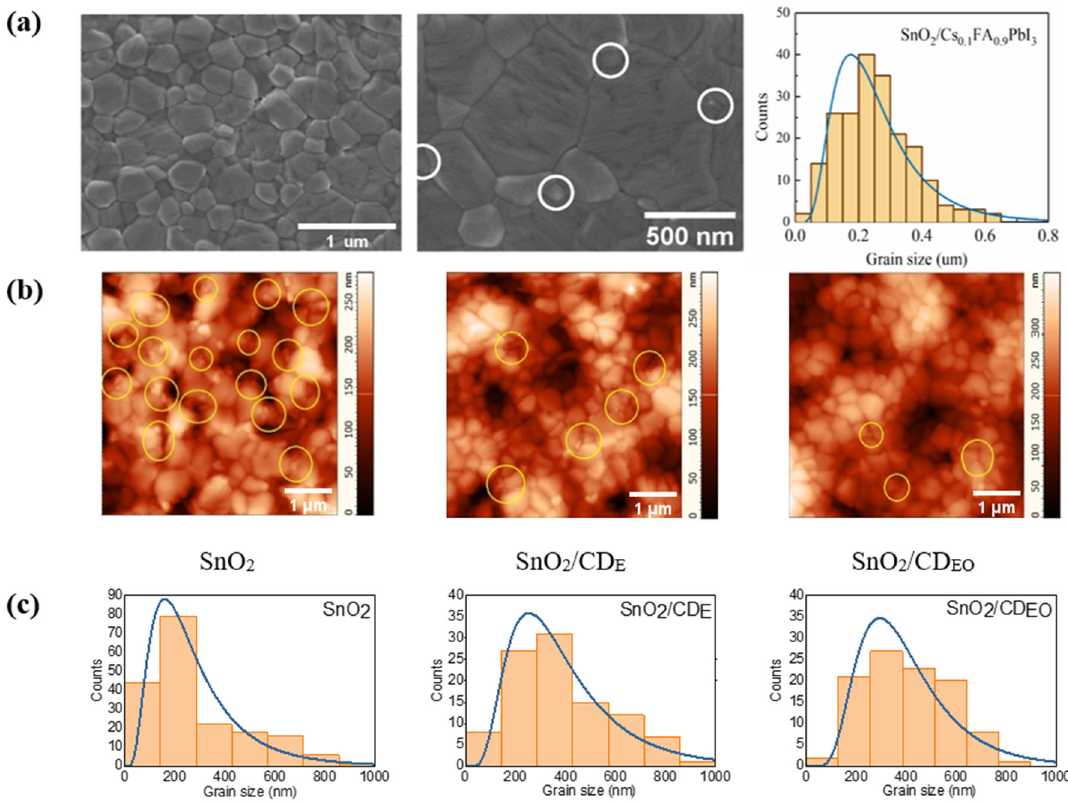
Figure 4. ( a ) SEM analysis of a polycrystalline Cs 0.1 FA 0.9 PbI 3 perovskite fi lm formed on pristine SnO 2 . AFM images ( b ) and grain size distributions ( c ) for Cs 0.1 FA 0.9 PbI 3 perovskite fi lms formed on ITO/SnO 2 , ITO/SnO 2 /CD E , and ITO/SnO 2 /CD EO .